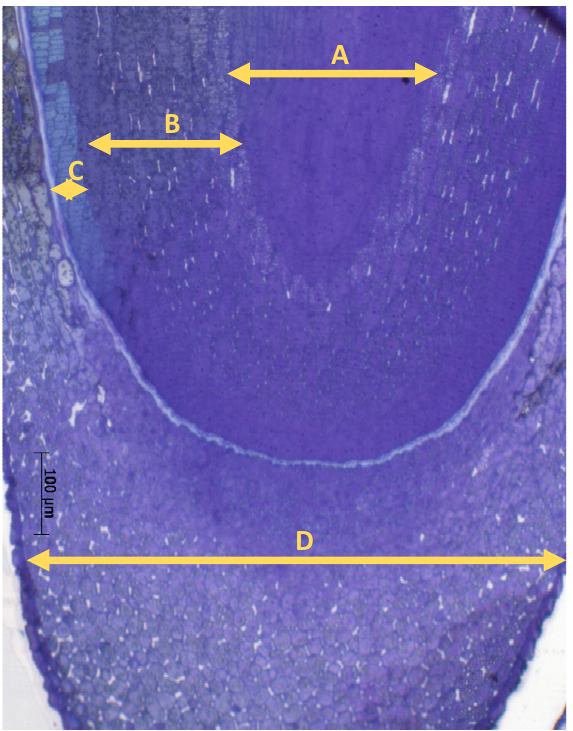
Figure 1. Light microscopy image showing the different tissues of the radicle tip: ( A ) pericycle; ( B ) cortex; ( C ) epidermis; ( D ) root cap. Magnification = 10×.